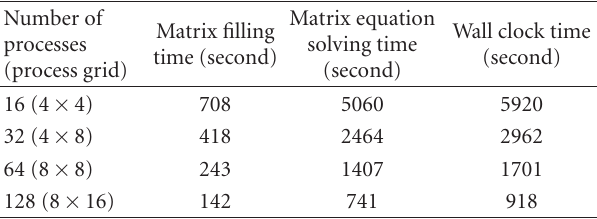
Table 3: Comparison of the simulation time of Y-8’s RCS with respect to